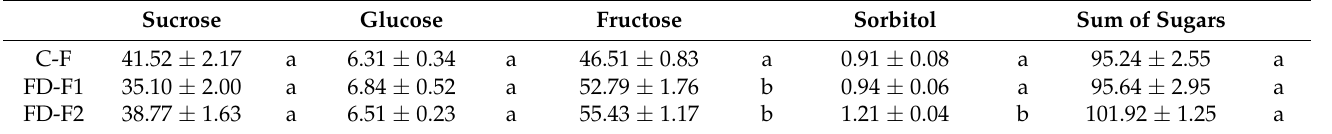
Table 1. The content of individual sugars and sum of sugars: sucrose, glucose, fructose and sorbitol (mean ± SE in g kg − 1 fresh weight) in flesh of undamaged apples (C-F), and damaged apples: flesh underneath healthy peel (FD-F1) and flesh underneath corky peel (FD-F2). Different letters in the columns denote statistical differences between treatments (the Duncan test, p < 0.05).